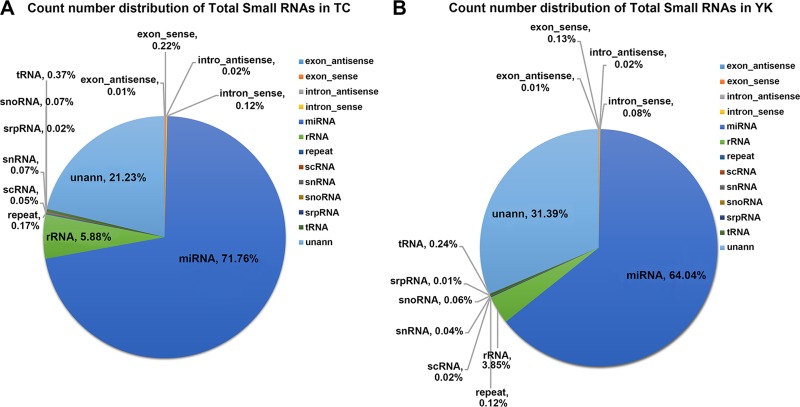
Small RNA annotation.Count number distribution of total small RNA in TC (A) and YK (B) breeds. TC: Tongcheng, YK: Yorkshire. unann: remaining non-annotated small RNAs after searching against miRbase, Genbank and Rfam.